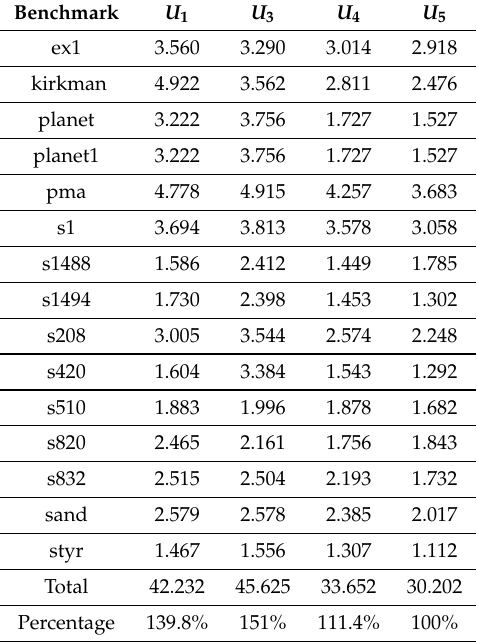
Table 10. Results of experiments (the consumed energy,